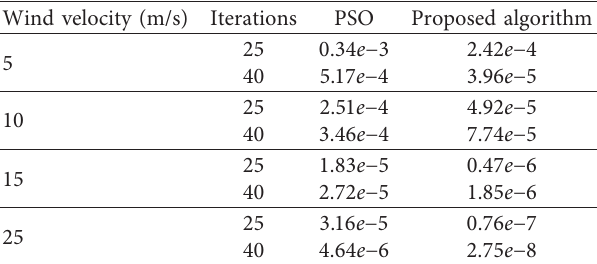
Table 4: Comparison of the error norm using different algorithms. Wind velocity (m/s)